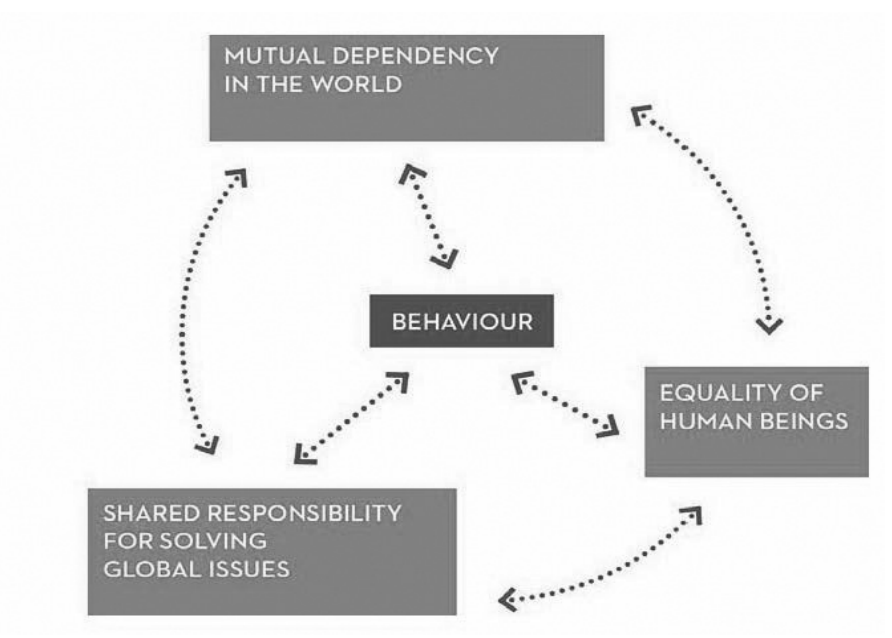
Figure 1: Graphic representation of definition on global citizenship